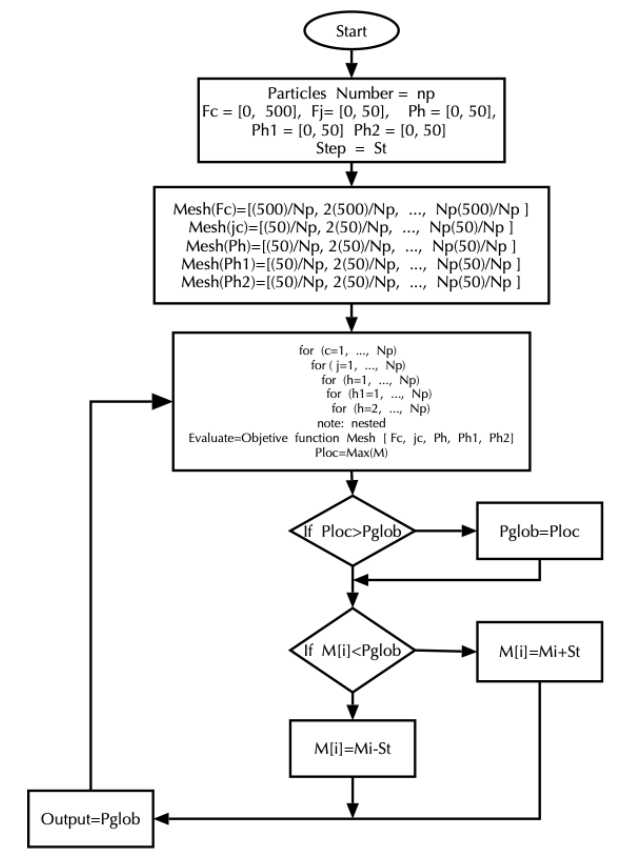
Figure 3. Proposed method based on pattern search to problem